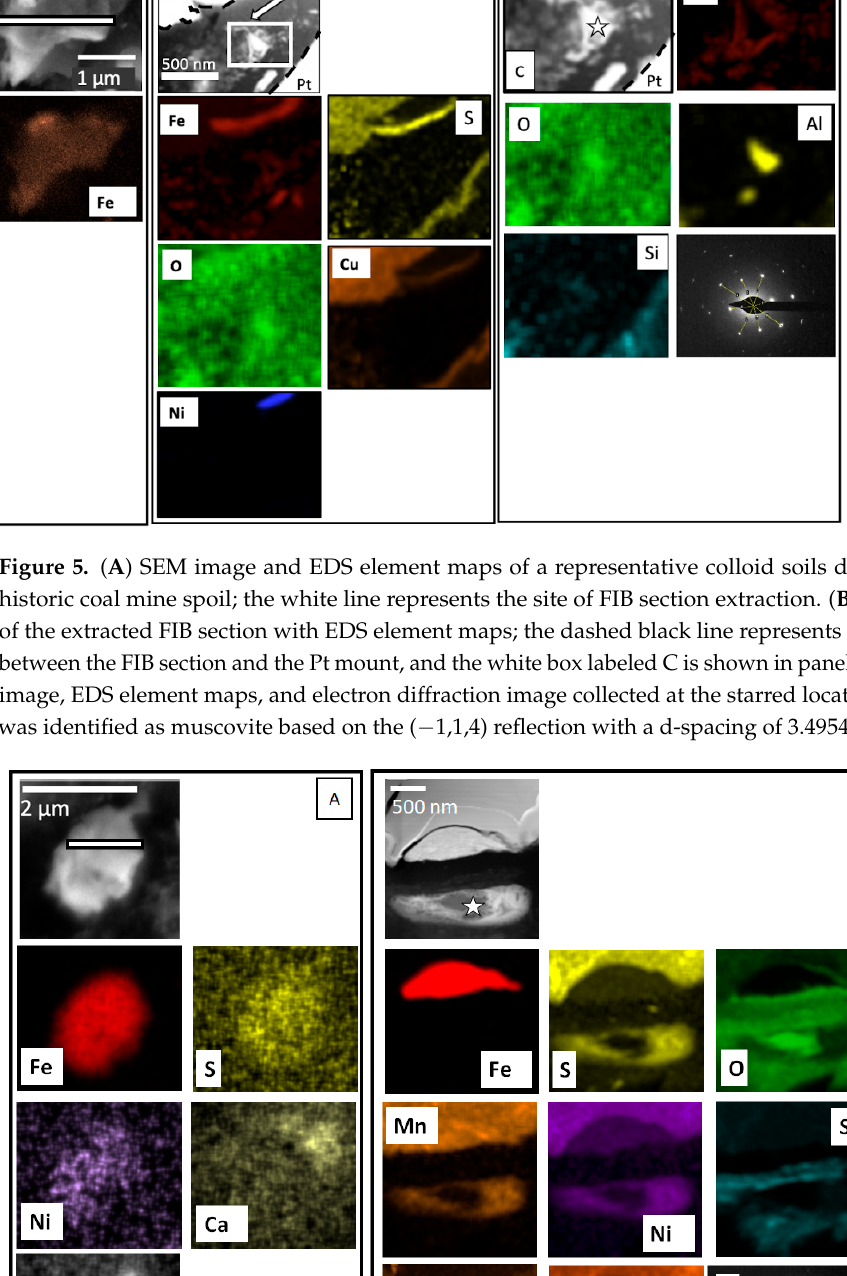
Figure 7. ( A ) SEM image and EDS element maps of a representative colloid soils developing on historic coal mine spoil; the white line represents the site of FIB section extraction; ( B ) TEM image of the extracted FIB section with EDS element maps. The dashed line represents the boundary be ‐ tween the FIB section and the Pt, and the white line represents the contact between targeted colloid and surrounding material.